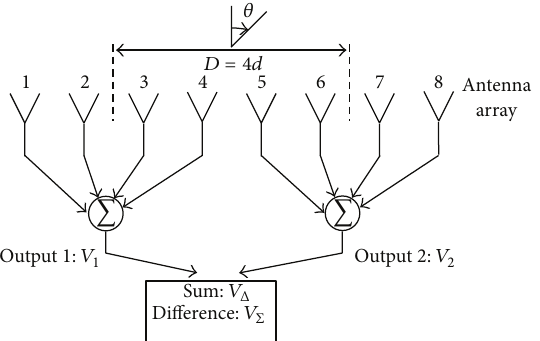
Figure 1: A phase-comparison monopulse system based on a conventional 8-element